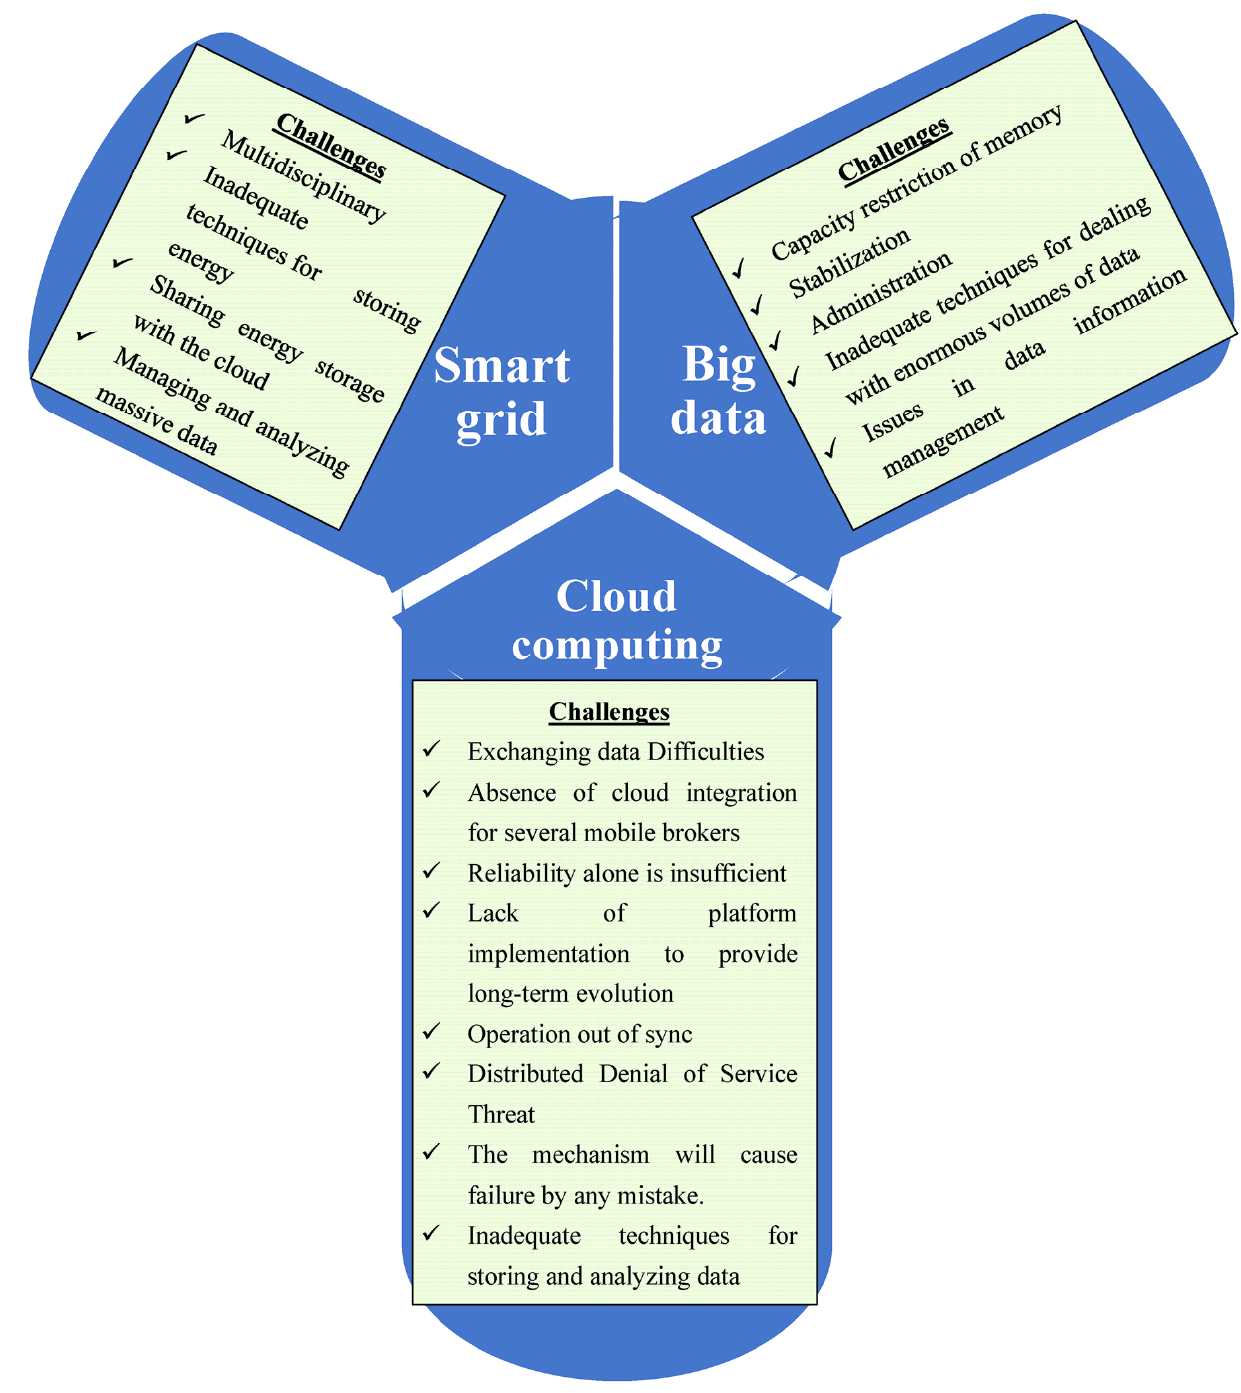
Figure 6. Key characteristics of large data in smart grids.